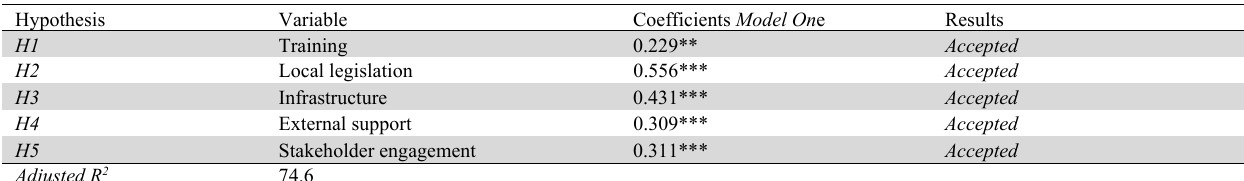
Results of the Regression